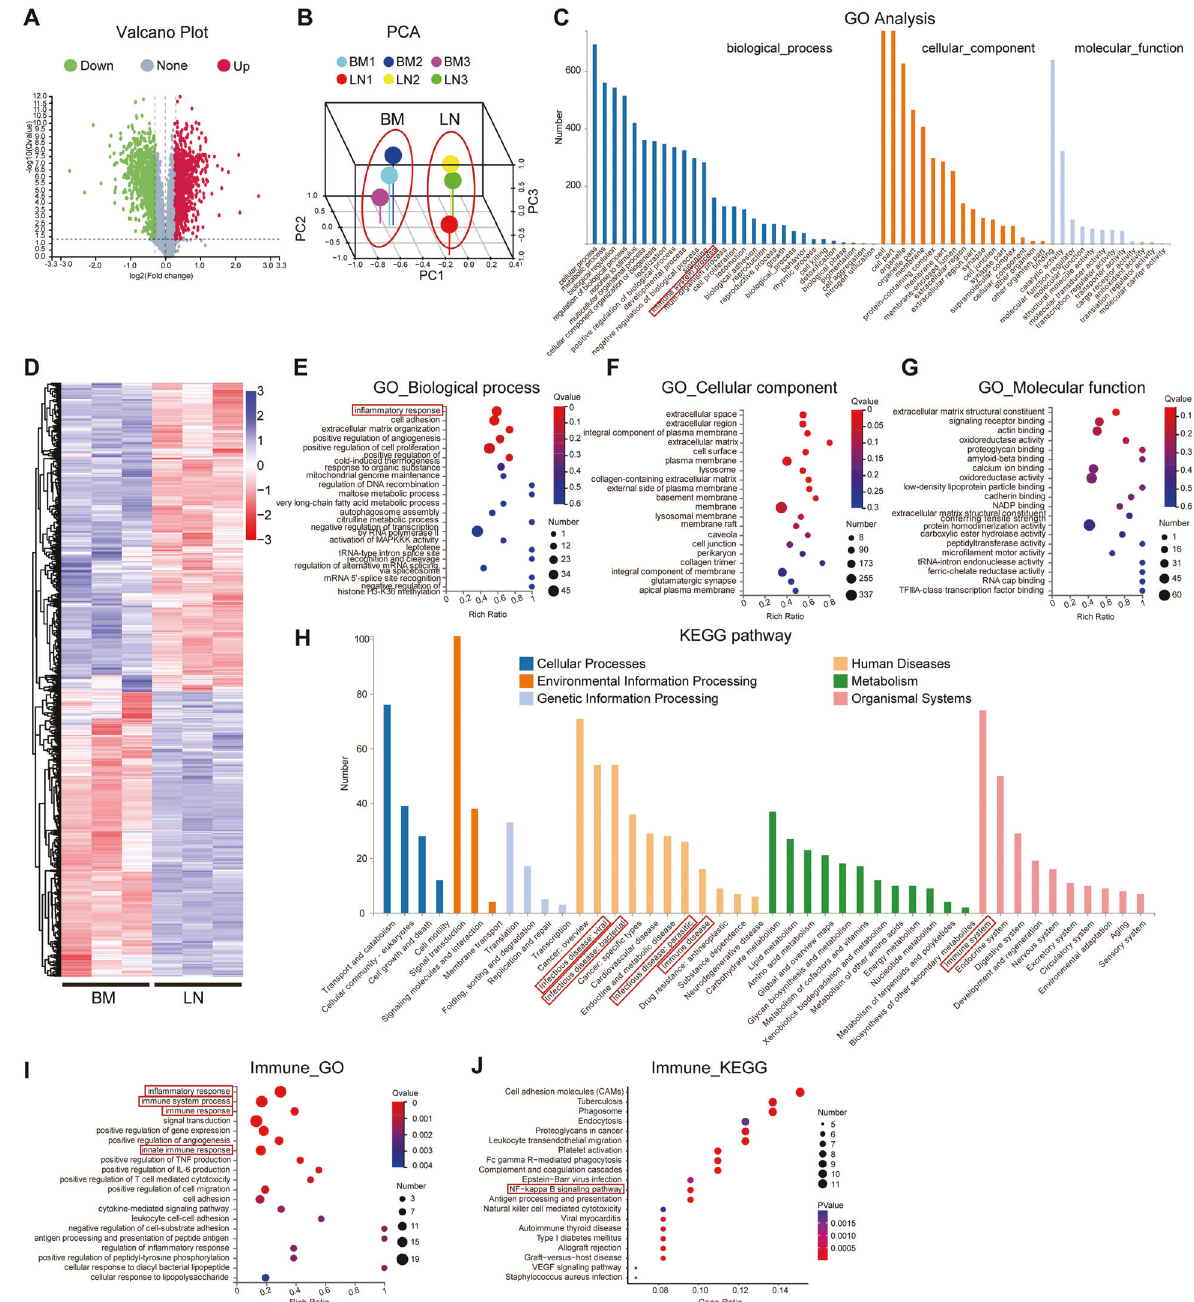
Fig. 3 iTRAQ quantitative proteomic comparison between LNMSCs and BMMSCs after co-culture with activated T cells. A Volcano plot showing the differentially expressed proteins (DEPs). B Principal component analysis showed obvious separation of samples from different groups. C GO classi fi ed annotation of differential expressed proteins. D Cluster heatmap of gene expression pro fi les. Blue indicates downregulation, red indicates up-regulation. E – G GO enrichment analysis of DEPs on biological process ( E ), cellular component ( F ), and molecular function ( G ) levels. H KEGG classi fi ed annotation of DEPs. I GO enrichment analysis of the immune process-related proteins of DEPs on biological process level. J KEGG analysis of the immune process-related proteins of DEPs. n =